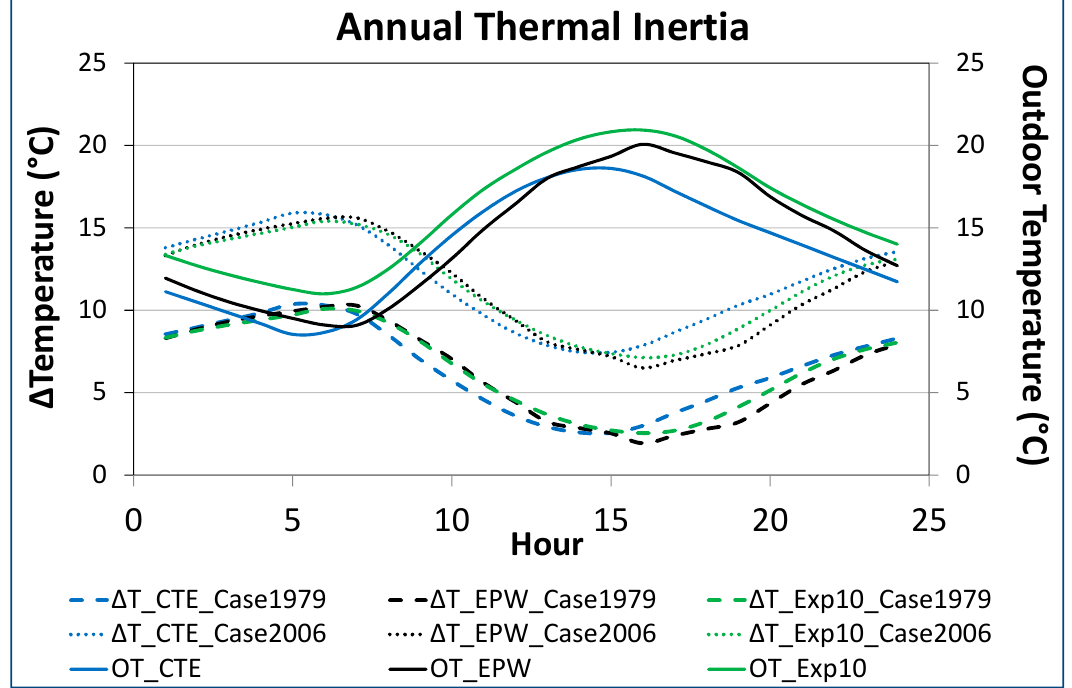
Figure 9. Annual thermal inertia: the difference between outdoor and indoor temperatures ( ∆ T) and Outdoor Temperature (OT), obtained for the three climate databases (CTE, EPW and Exp10) and for the two building models, Case 1979 and Case 2006.